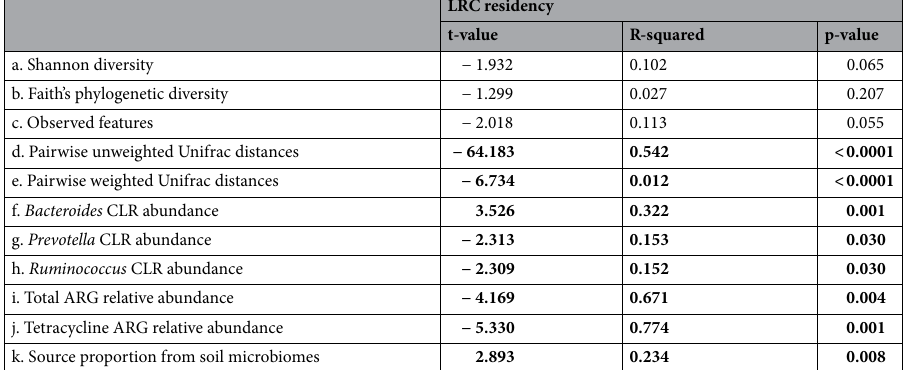
Table 2. Results of linear mixed modeling for measures of lemur gut microbiome (a–c) diversity, (d,e) composition, (f–h) center log-ratio (CLR)-transformed abundance of bacterial taxa, (i,j) antibiotic resistance genes, and (k) covariation between lemur and soil microbiomes. The model included the duration of residency at the Lemur Rescue Center (LRC) as a fixed effect. Significant results are